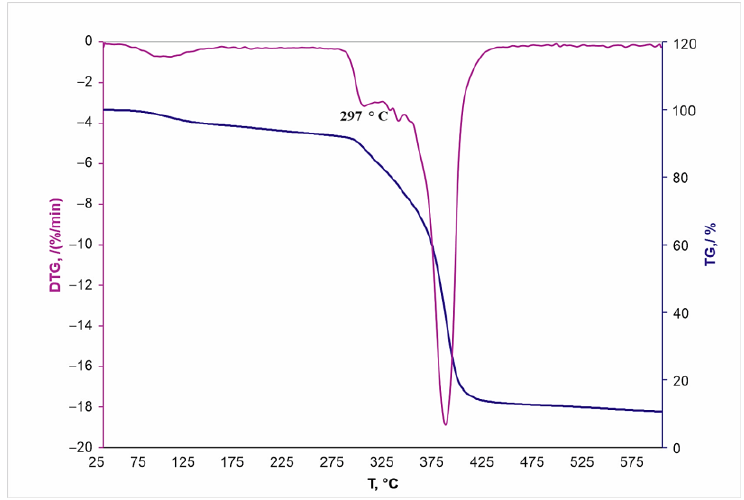
Figure 6. TG and DTG for BU[6].